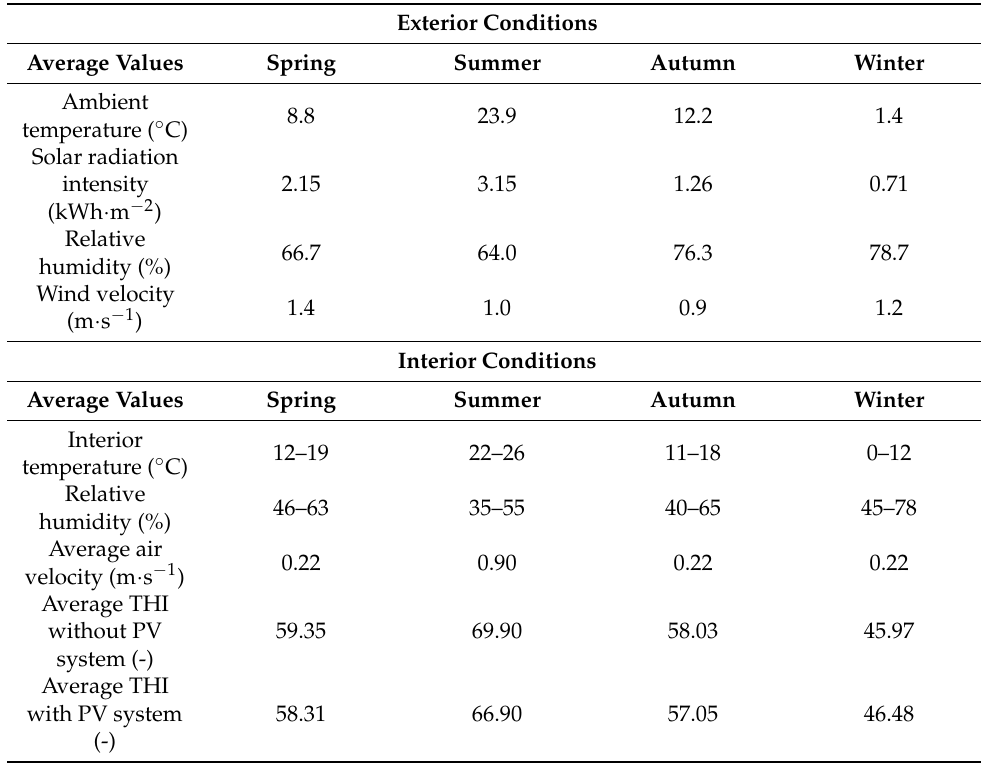
Table 3. The summary of external and internal conditions in context of Temperature—Humidity— Index